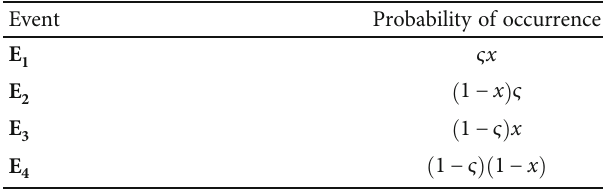
Table 2: The movement of a rat and its corresponding events. Table 3: Corresponding probabilities of the four